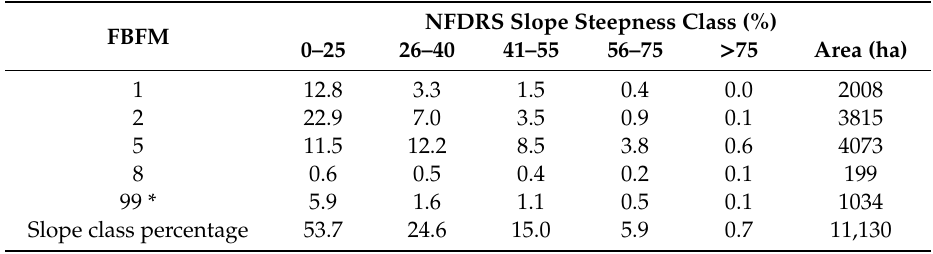
Figure 6. Map of Anderson [32] fire behavior fuel models for Army Garrison Camp Williams as predicted using random forests at 0.5 m resolution.